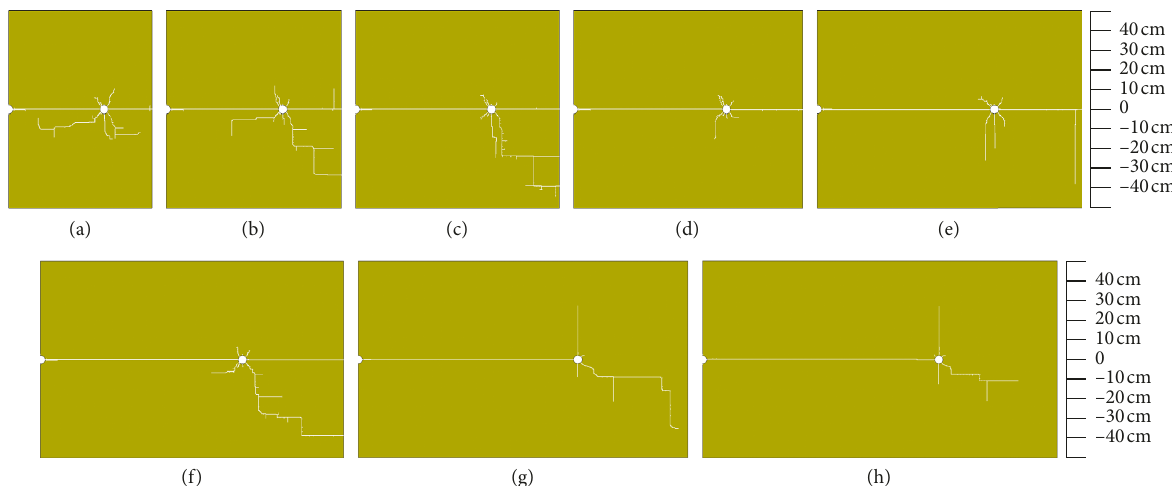
Figure 19: Cracks formation diagram under different blast hole spacing when PBH is a notch hole. (a) H � 50 cm. (b) H � 60cm. (c) H � 70cm. (d) H � 80cm. (e) H � 90cm. (f) H � 100cm. (g) H � 110 cm. (h) H �